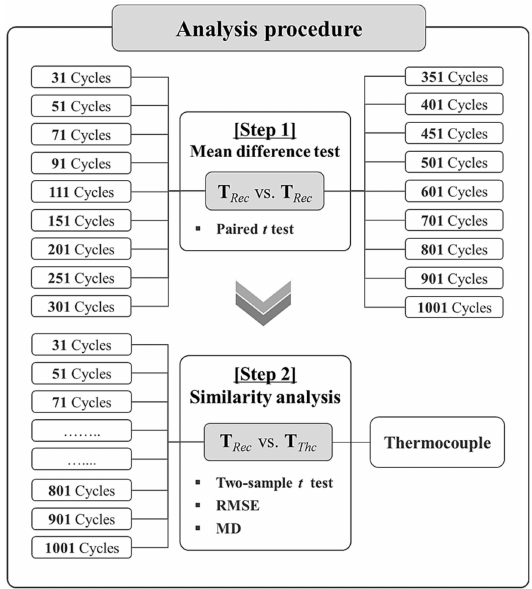
Figure 8. Procedure for mean di ff erent test and similarity